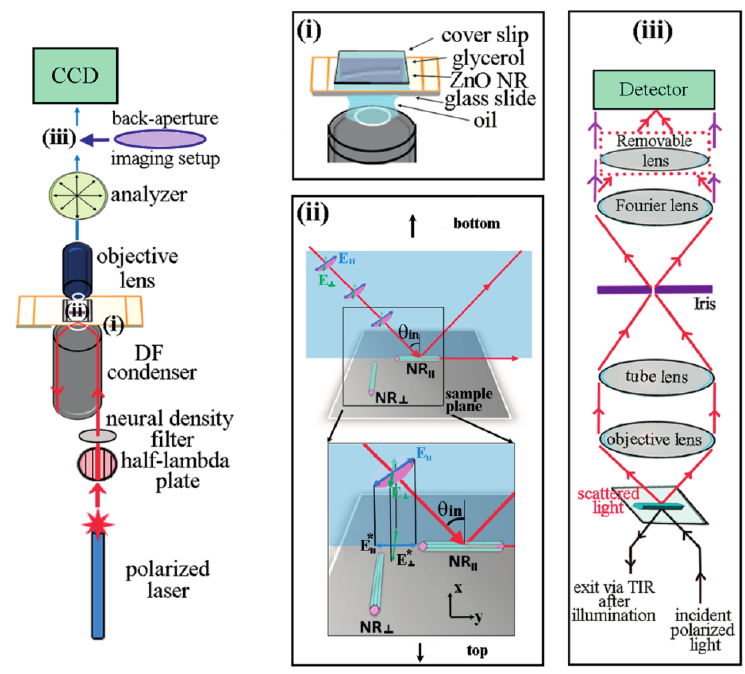
Figure 1. Schematic illustrations showing the experimental setup to measure the NR position- and NR orientation-dependent scattering signal as well as to detect the back-aperture signal from individual ZnO NRs while controlling excitation and collection polarization angles. Three key measurement points in the setup, shown as (i), (ii), and (iii) are displayed in detail inside the boxed panels: (i) sample assembly to achieve refractive index matching for all measurement components and optics, (ii) two distinctive directions for the incoming polarized laser and the two different NR orientations on the measurement plane, and (iii) optical elements to perform forward DF scattering and back-aperture imaging from the same individual NRs. The diagram shown in (ii) is a 180° rotated view of the sample plane and incident light in order to describe the two polarized light directions of E ║ and E ┴ . The incident angle of the laser, noted as θ in in the diagram, is 62° in our experimental setup. The two orthogonal axes of the sample plane are labelled as x and y. The * sign next to E marks the projected components of the electric field onto the sample